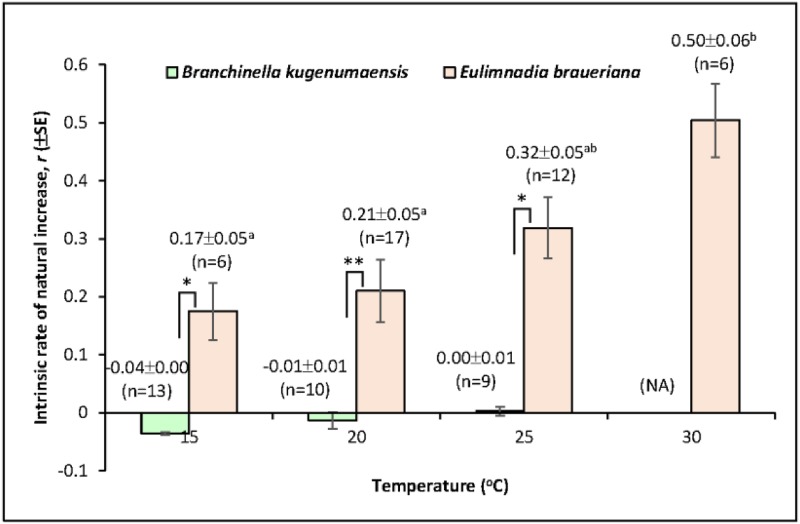
Intrinsic rates of natural increase (r) at different temperatures from B. kugenumaensis and E. braueriana.The symbol star (*) indicated significant difference of r between B. kugenumaensis and E. braueriana (*p < 0.050, **p < 0.010). Different superscript letters (a, b) indicated the significant pairwise groups by post hoc analysis.